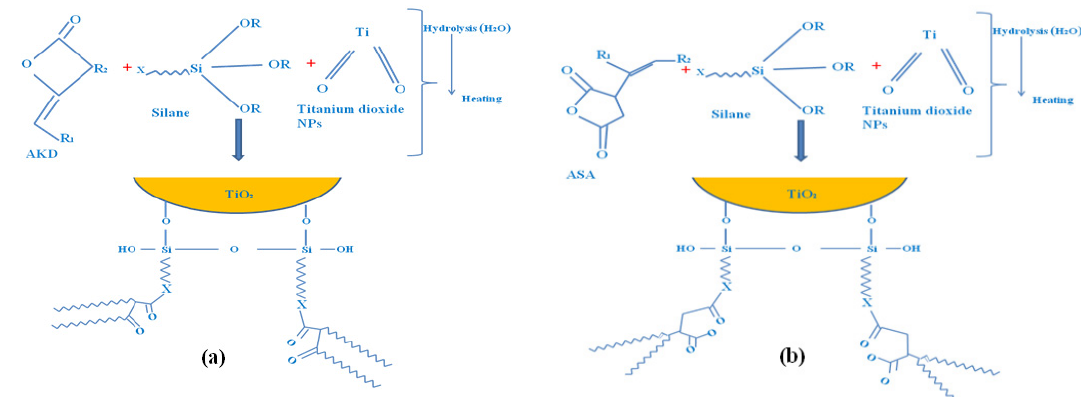
Figure 5. Reaction mechanism model: ( a ) TiO 2 NPs/AKD; ( b ) TiO 2